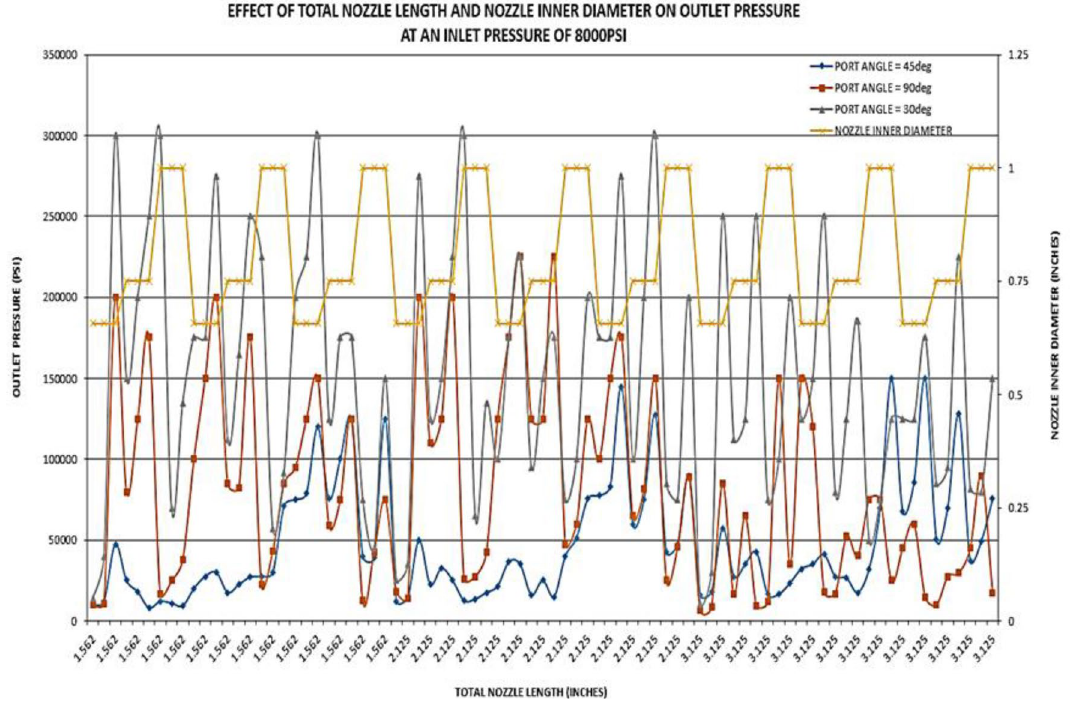
Fig. 12 Effect of total nozzle length and nozzle inner diameter on outlet pressure at an inlet pressure of 5000